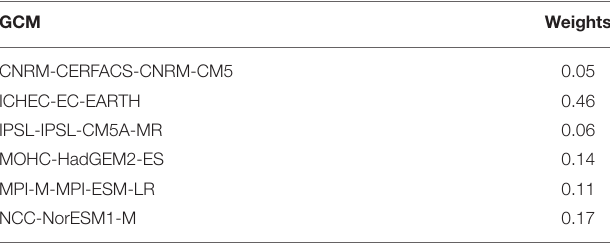
TABLE 8 | Weights determined by the method of Brunner et al. (2019).